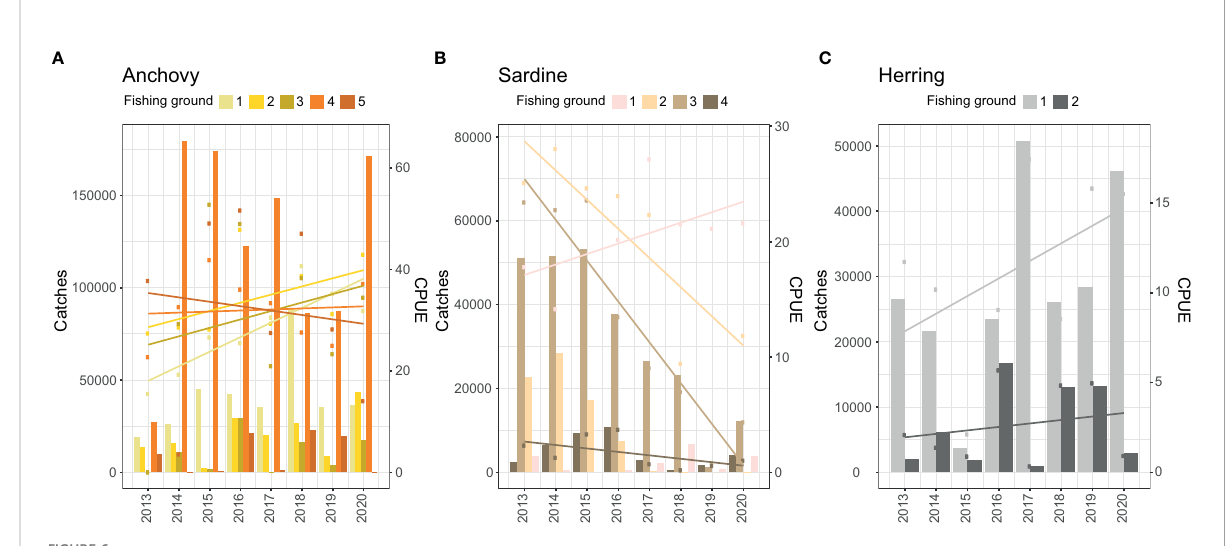
FIGURE 6 Trends in fi sh catches (bars, in tons) and CPUE (data points and regression lines; see Table 2 for linear regression slopes) against year (for the period 2013-2020) per main fi shing ground (see Figs. 5 and S3 for locations) for anchovy (A) , sardine (B) , and herring (C) , revealed that areas further from species-speci fi c hot spots are those showing the most ‘ positive ’ trends in